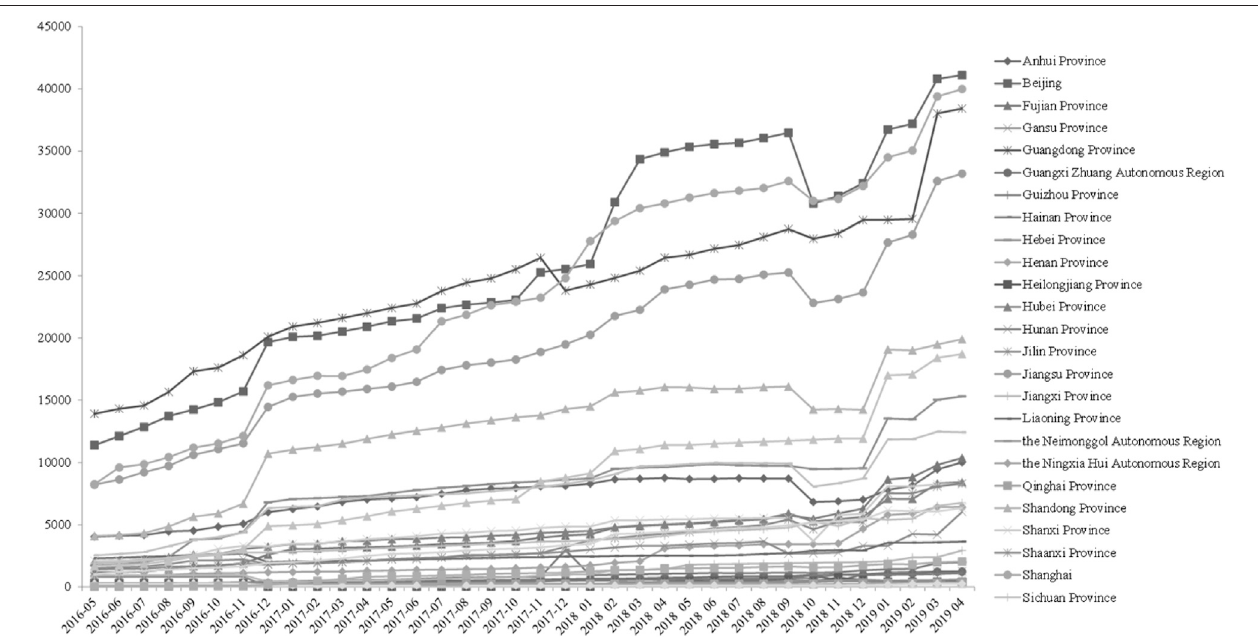
FIGURE 9 | Monthly increases in the number of public charging piles in all provinces.